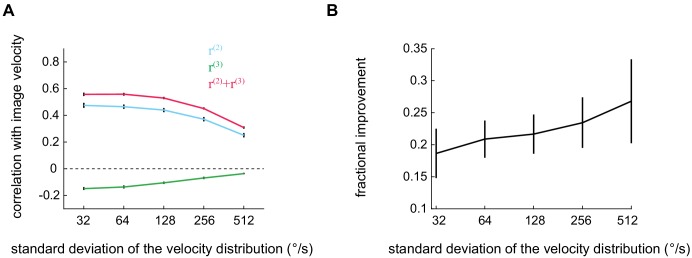
The improvement added by the third-order kernel persists across a wide range of velocities.(A) Pearson correlation coefficient between the true image velocity and the second-order, third-order, and full outputs as a function of the standard deviation of the velocity distribution. (B) The improvement added by the third-order kernel as a function of the velocity standard deviation.